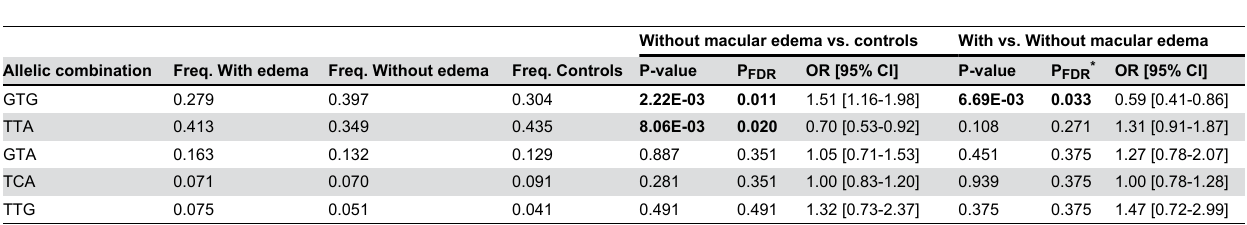
Table 3. Different allelic combinations of the IRF5 genomic region according to the presence/absence of macular edema in uveitis patients.